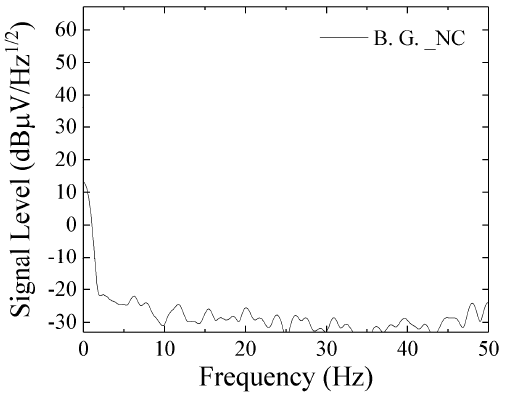
Figure 14. Noise level of measurement apparatus RSA3408A only.